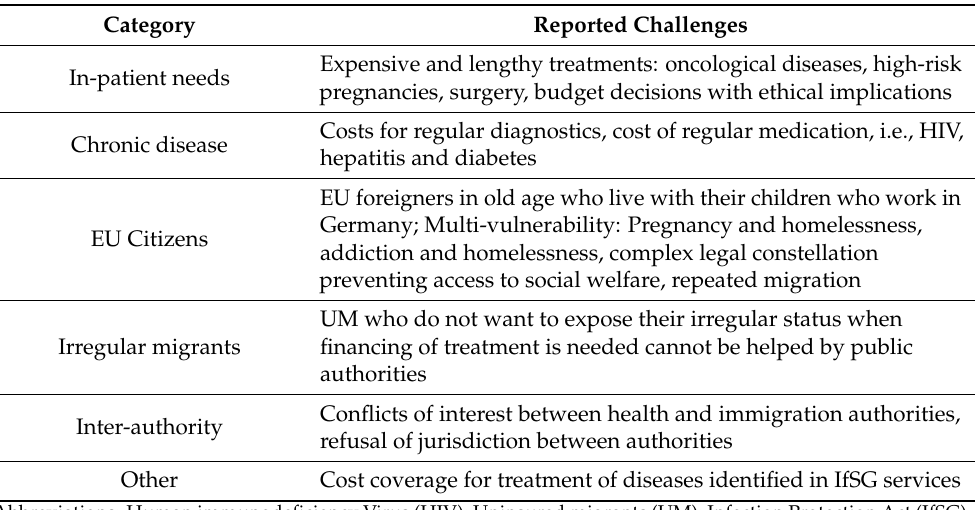
Table 3. Summary of reported challenges in provision of health care in the work with UM by experts. Category Reported Challenges Expensive and lengthy treatments: oncological diseases, high-risk In-patient needs pregnancies, surgery, budget decisions with ethical implications Costs for regular diagnostics, cost of regular medication, i.e., HIV, Chronic disease hepatitis and diabetes EU foreigners in old age who live with their children who work in Germany; Multi-vulnerability: Pregnancy and homelessness, EU Citizens addiction and homelessness, complex legal constellation preventing access to social welfare, repeated migration UM who do not want to expose their irregular status when Irregular migrants financing of treatment is needed cannot be helped by public authorities Conflicts of interest between health and immigration authorities, Inter-authority refusal of jurisdiction between authorities